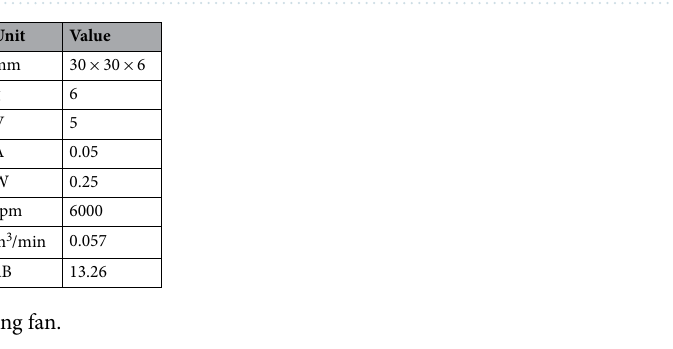
Figure 4. Performance evaluation of fabric muscle under NCC. ( a ) Changes in displacement of fabric muscle measured during Joule heating and NCC according to input current under 4 kg load condition. ( b ) Comparison of maximum displacement (blue line), contraction strain (yellow bar-graph), and heating temperature (red dot-line) of fabric muscle according to input current. ( c ) Generated force of the fabric muscle depending on the input current under the isometric condition. ( d ) Normalization result of the force data measured in ( c ).